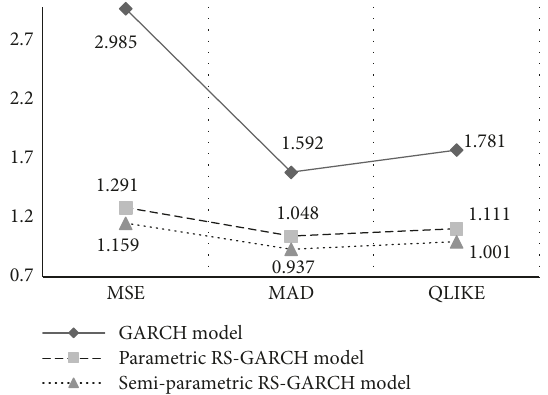
Figure 7: The modelfitting error results in sample period (CSI 300).